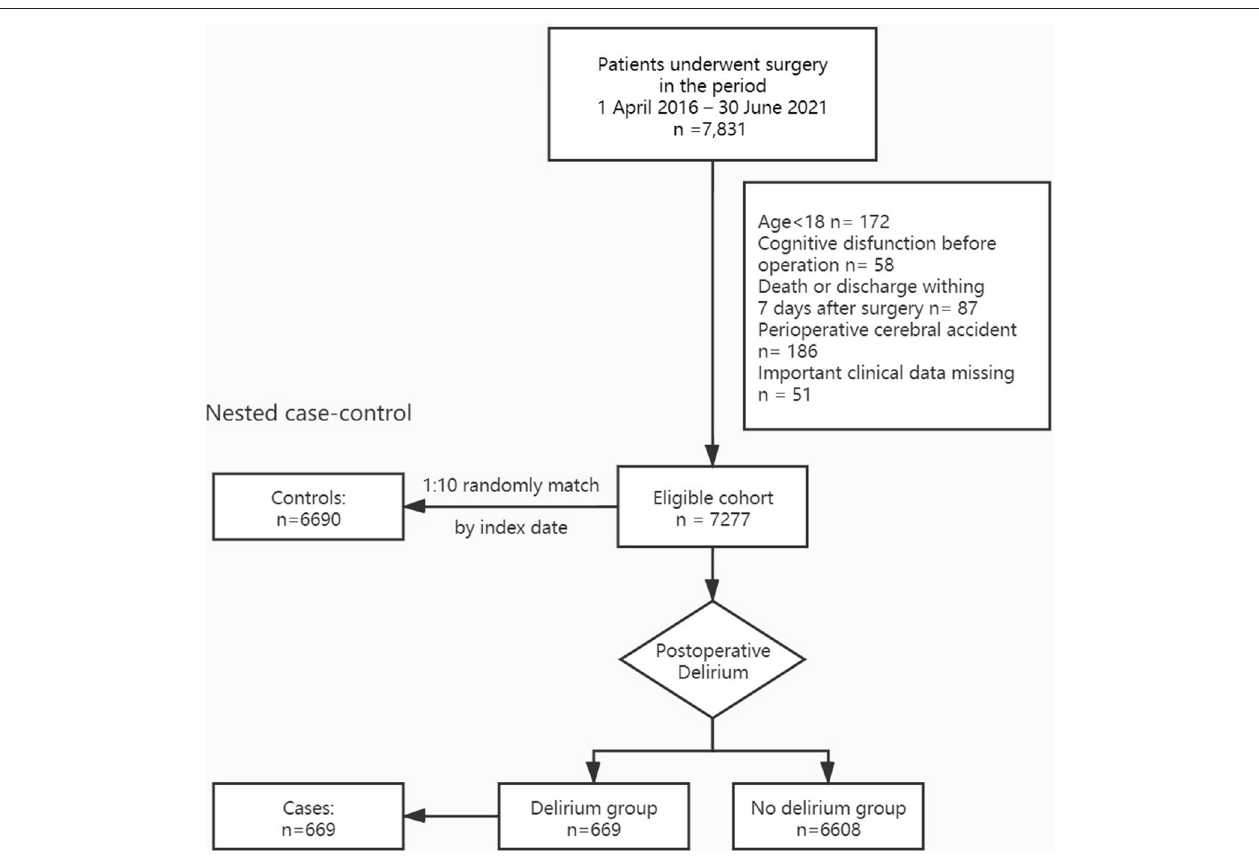
FIGURE 1 | Flow chart of the study